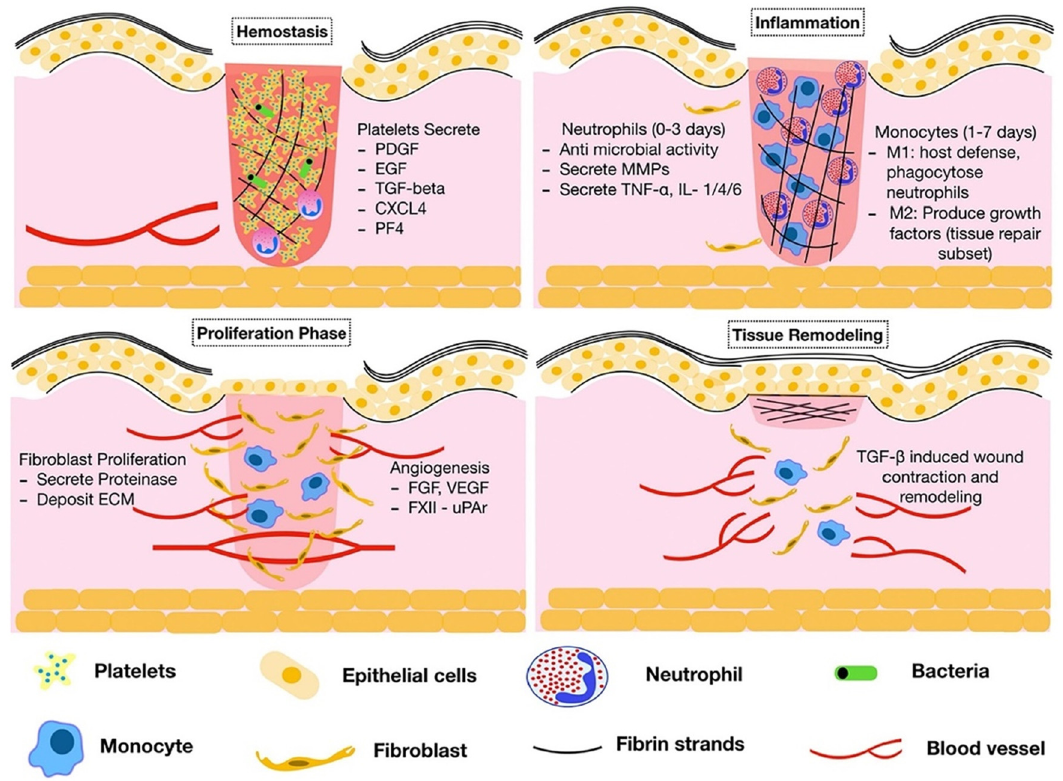
Figure 2: The stages of wound repair and their major cellular components [ 28 ] . The process of skin wound healing can be divided into four continuous stages, namely, hemostasis, in fl ammation, proliferation, and remodeling.